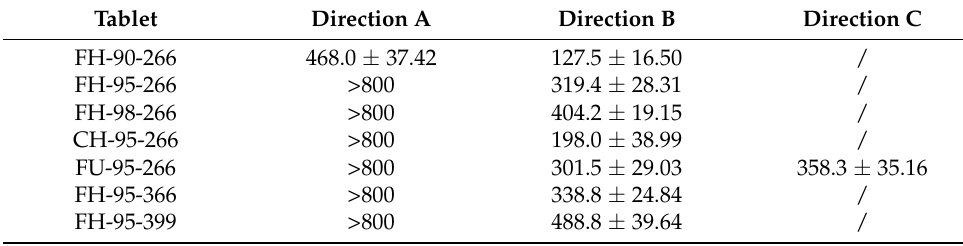
Table 3. Hardness of the core–shell 3D-printed tablets (mean ± SD) ( n = 6).